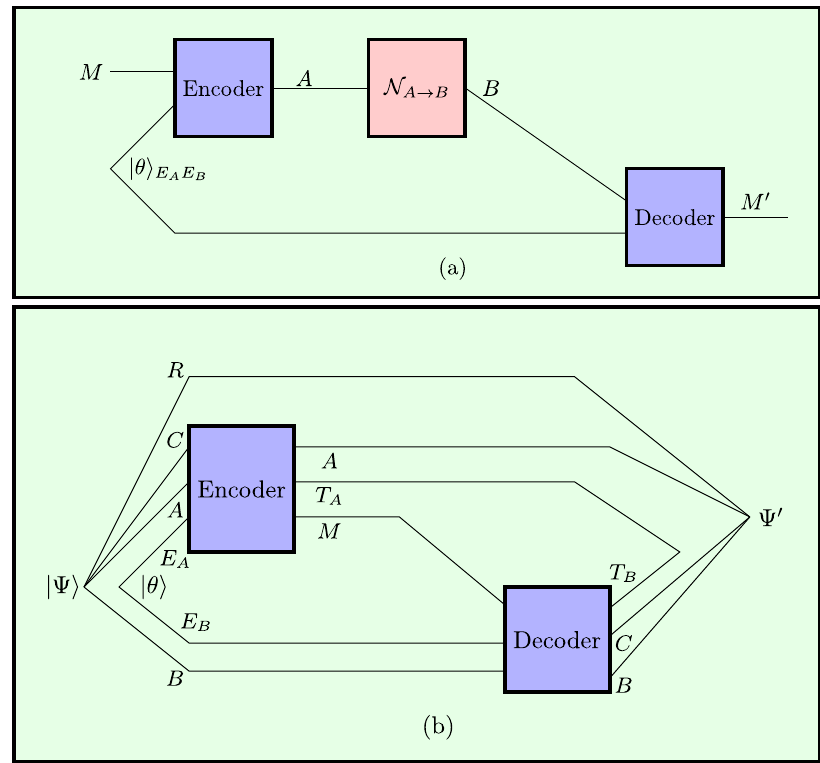
Fig. 2 Quantum communication tasks. Figure a depicts the task of entanglement-assisted quantum channel coding, where the register M holds a message m ∈ {1, 2, … 2 R }. The goal is to maximize the value of R , while keeping the error in decoding small. Figure b shows the task of quantum state redistribution with entanglement assistance. The goal is to ensure that the register C is obtained by Bob using as less communication log j M j as possible and ensuring that Ψ 0 (cid:3) Ψ j i Ψ h j